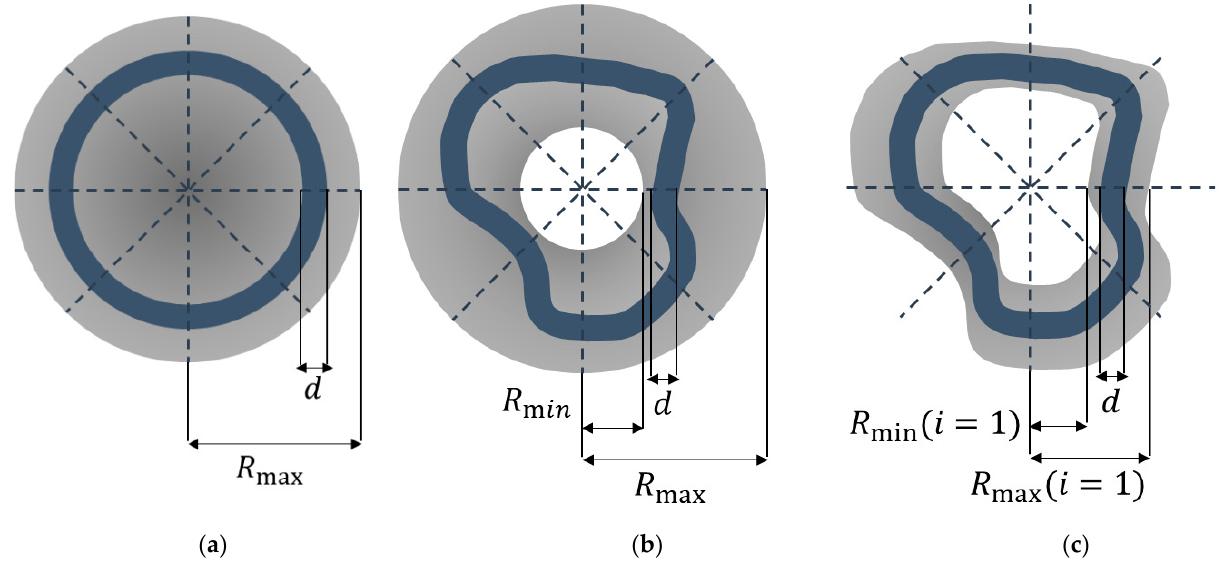
Figure 5. Some specific LCI filters: ( a ) adaptive ring filter; ( b ) sliding band filter, and ( c ) deformable region filter, where the search region is specified in dark gray and the region with the maximum filter response (support region) is specified in dark blue.